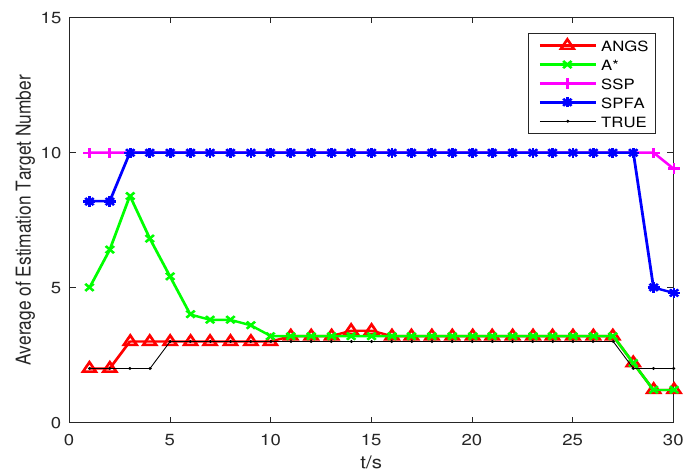
Figure 6. The average of the estimated numbers of targets in scenario 1.